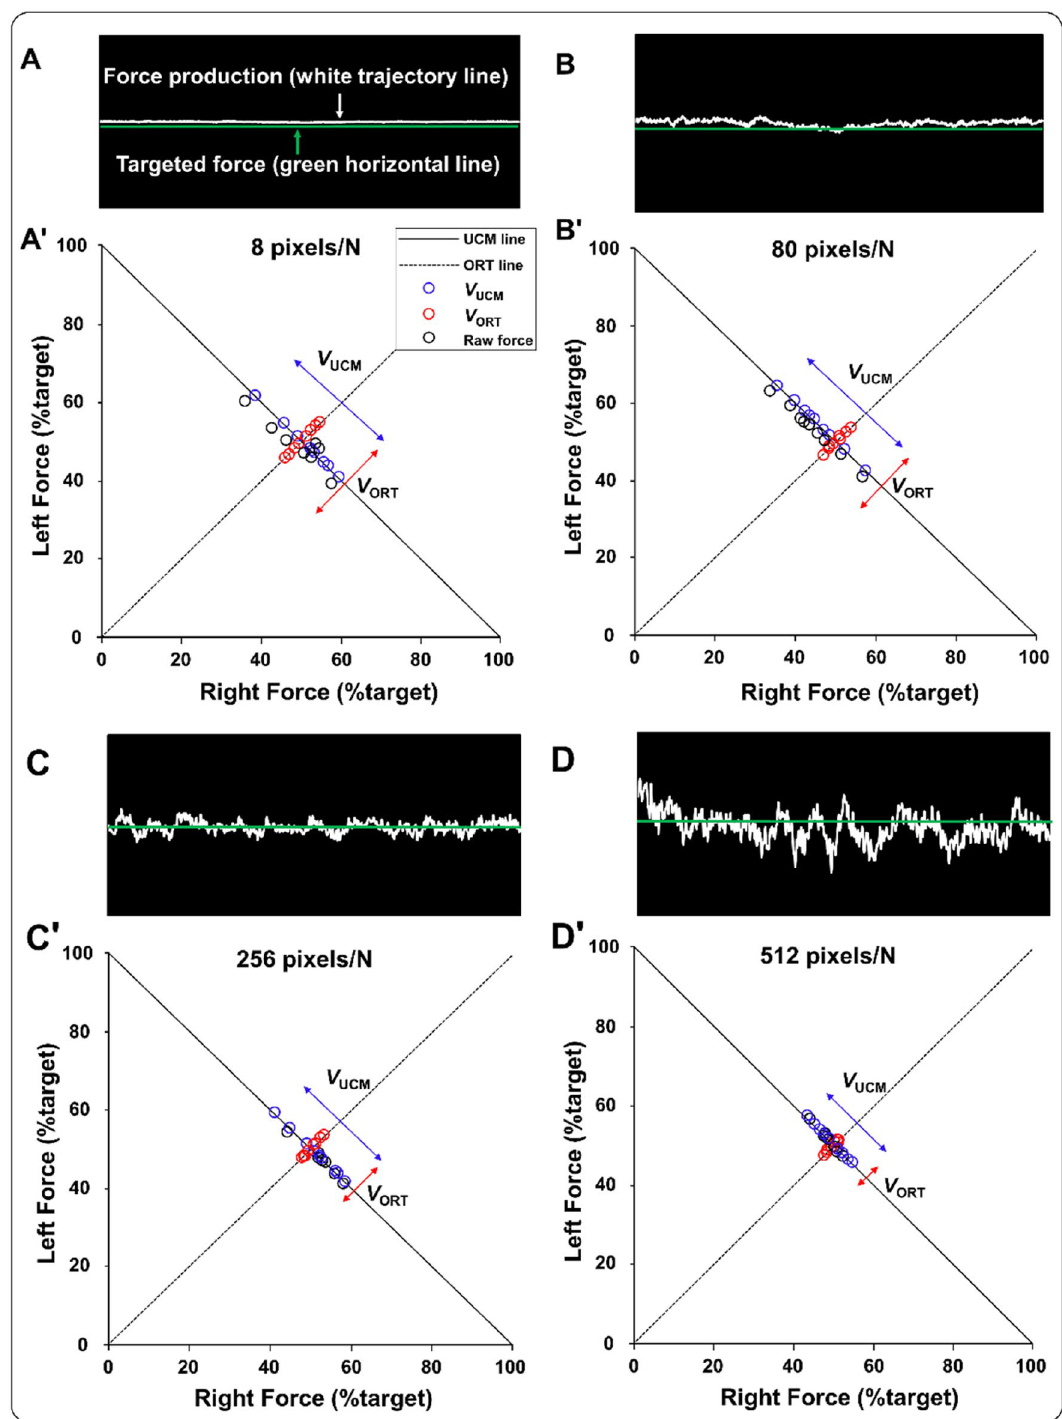
Figure 1. Representative force fluctuation (upper) and UCM data (lower) at visual gain. Force fluctuation figures displays force production (white trajectory line) and targeted force level (green horizontal line). ( A ) 8 pixels/N, ( B ) 80 pixels/N, ( C ) 256 pixels/N, and ( D ) 512 pixels/N. UCM analysis quantifying variances of nine pairs of normalized elemental variables from each trial (i.e., black circles) projected to both UCM (i.e., black line) and ORT (i.e., black dotted line). ( A ′ ) 8 pixels/N, ( B ′ ) 80 pixels/N, ( C ′ ) 256 pixels/N, and ( D ′ ) 512